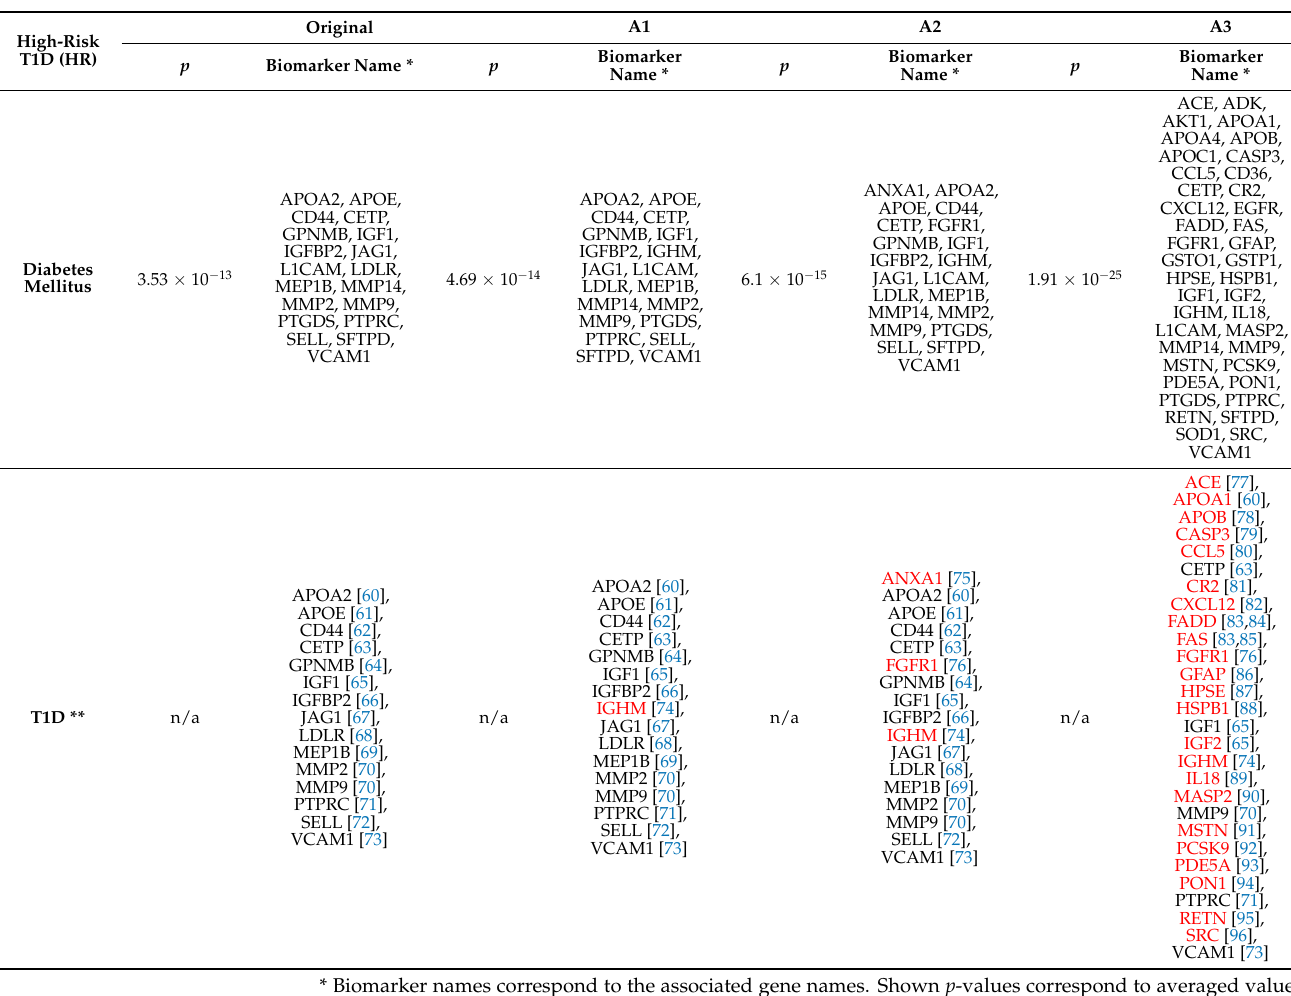
Table 2. Consolidated lists of candidate biomarkers predicted by IPA in the context of “diabetes mellitus” (top row) in the original and amplified datasets of the T1D high-risk subject group without any further data filtration or curation based on expression fold-change, and those among them that were confirmed as relevant to T1D based on published references (bottom